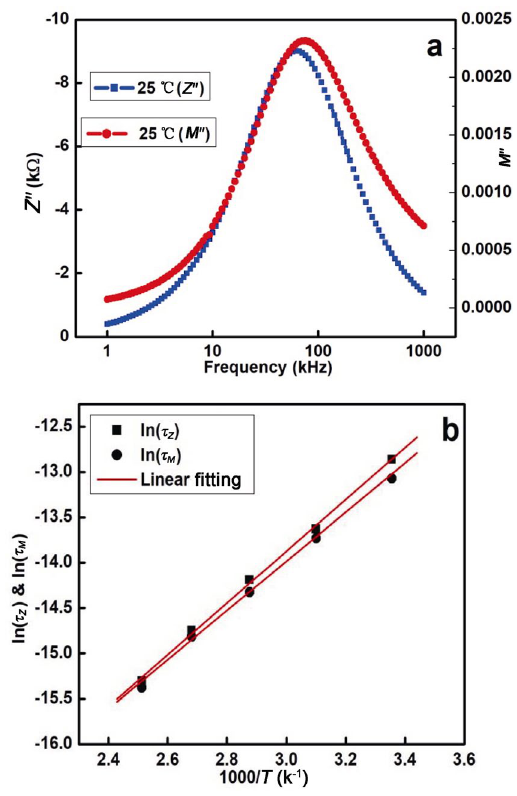
Fig. 9 (a) Graph of M ″ and Z ″ with frequency at 25 ℃ and (b) ln τ r ( r = Z , M ) vs. 1000/ T of the studied sample.